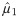
True and estimated stimulus transition contingencies for two example participants.(A) Transitions between pairs of stimuli, from trial t-1 to trial t, were defined by TMs. Every 50 trials, the TM switched to a different matrix. (B) Each panel corresponds to 1 of 16 possible transitions between stimuli across 1,200 trials. The black lines indicate the true transition contingencies. The blue lines reflect the participant’s inferred estimates (i.e., the posterior expectation of these contingencies, μ^1), before seeing the stimulus outcome on each trial. The model tracked the true underlying contingencies and detected change points. In a representative participant from the Placebo group, the model tracked the true transition contingencies closely. An example participant from the ACh- group showed a greater discrepancy in the tracking of the true transition contingencies. This is reflected in the two participants’ ω estimates: Placebo Participant 2 showed a higher transition contingency learning rate (ω = −3.27) than ACh- Participant 16 (ω = −5.84). http://dx.doi.org/10.6084/m9.figshare.3796362.v2.